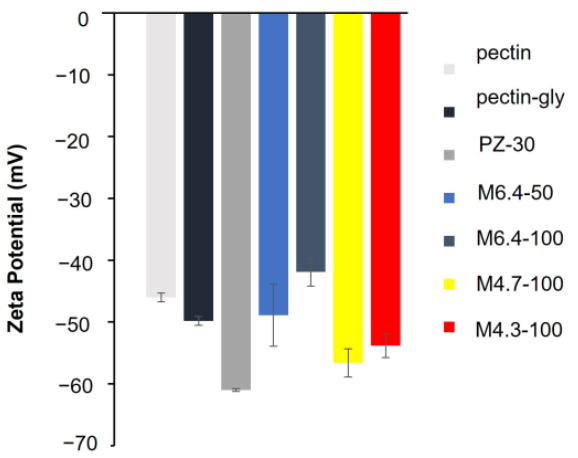
Figure 2. Zeta potential values of hydrogel samples in solution.